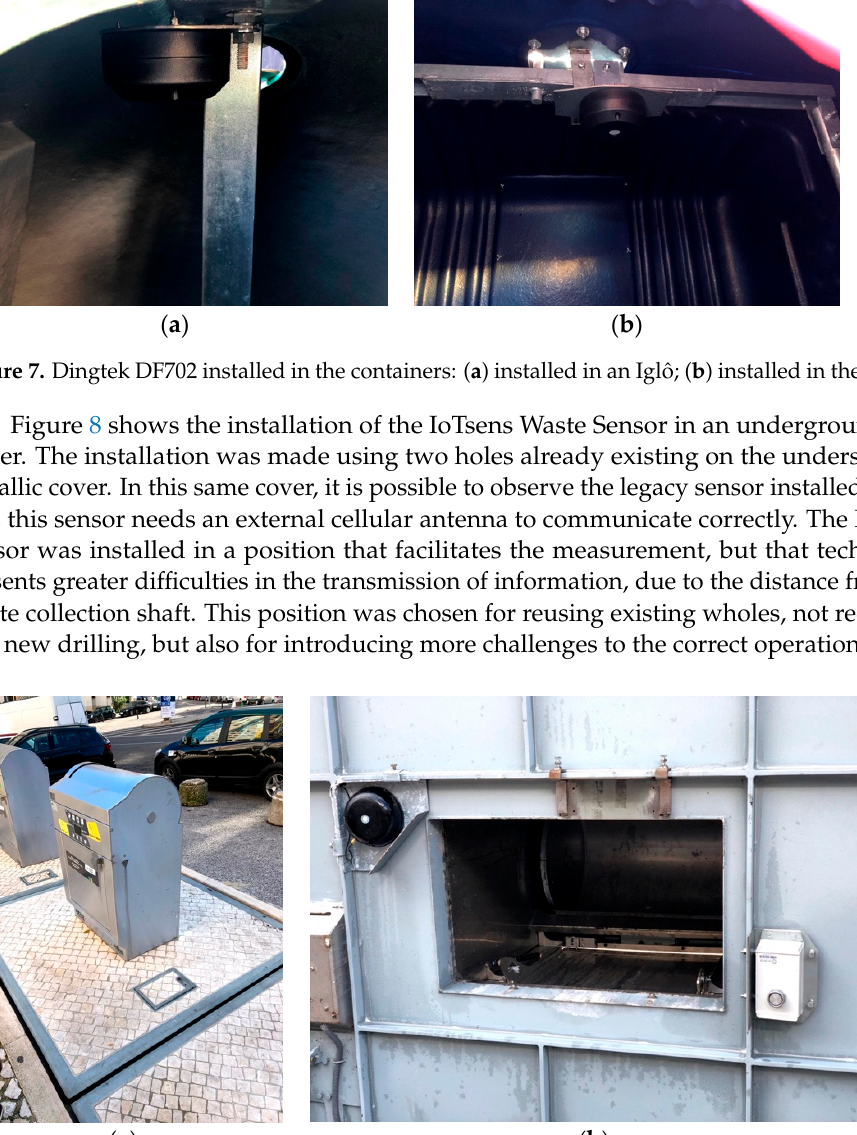
Figure 6. Cyclea (blue) and Iglô (green) containers installed at ISEL.